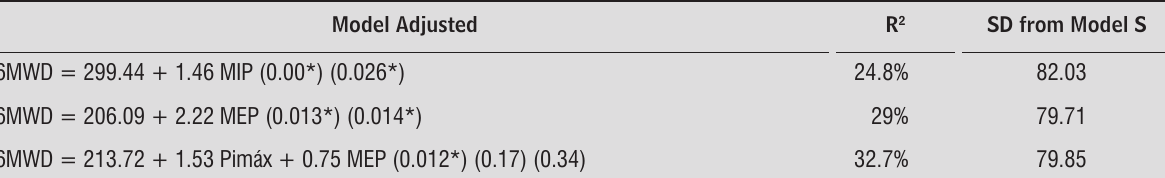
Table 5 - Independent contribution of maximal respiratory pressures in 6MWD performance